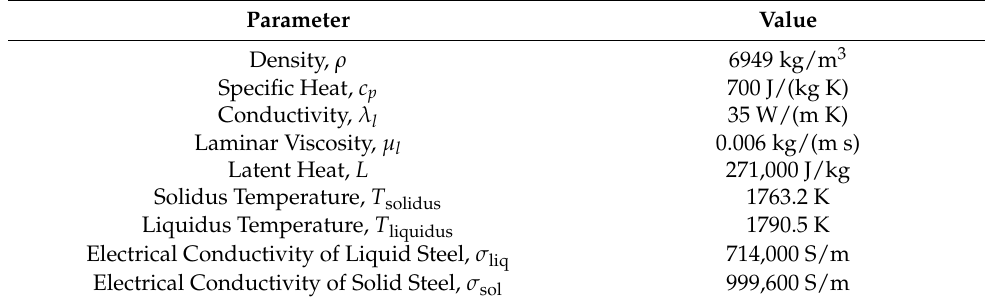
Table 3. Material